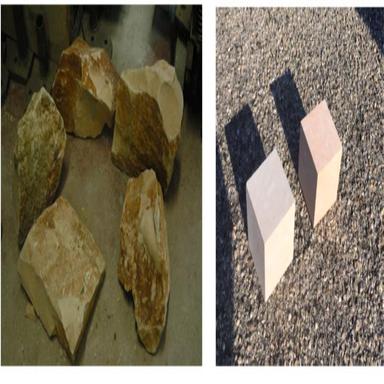
"Scaglia Rossa" stone (a) and cubic specimens derived from the cut (b).